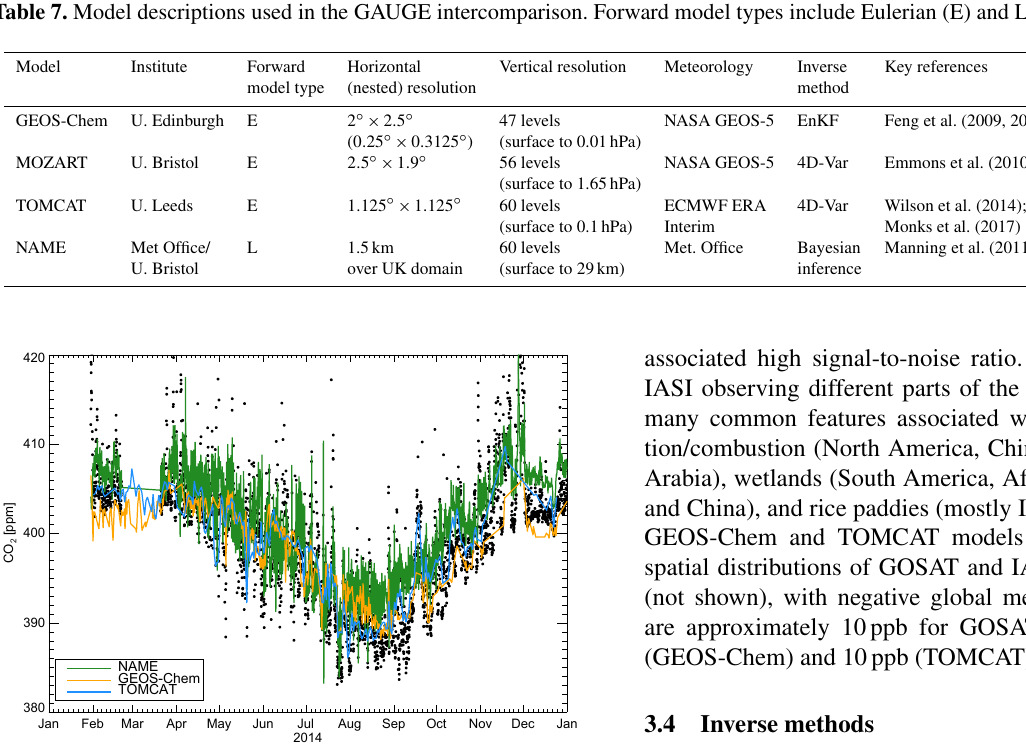
Figure 10. Observed and model atmospheric CO 2 mole fraction values at the Bilsdale tall tower during 2014 (Fig. 2 and Table 1). All models are sampled at the latitude and longitude and the 250m inlet altitude of the Bilsdale